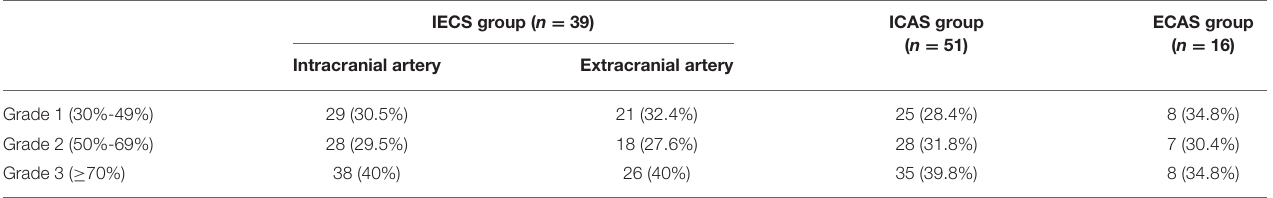
TABLE 1 | Numbers, percentages, and grades of arteries with stenosis in the IECS, ICAS, and ECAS groups. IECS group ( n =